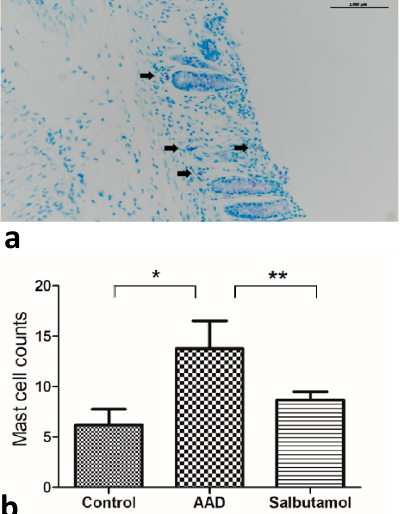
Figure 4. Evaluation of mucosal mast cells. ( a ) Toluidine blue staining of mast cells. ( b ) The number of mast cells in each group was counted and compared among the groups. * p < 0.05, ** p = 0.068.